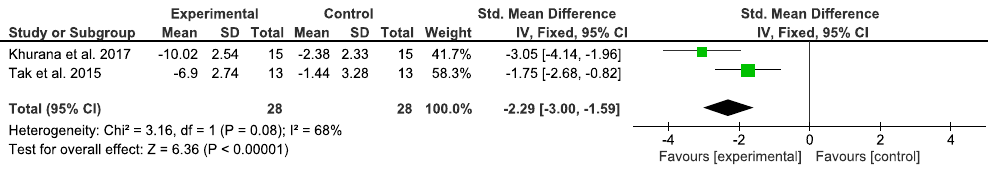
Figure 4. Forest plot for balance measured by the modified Functional Reach Test. Green block indicates the weight assigned to the study and the horizontal line depicts the confidence interval. Black rhombus shows the overall result.